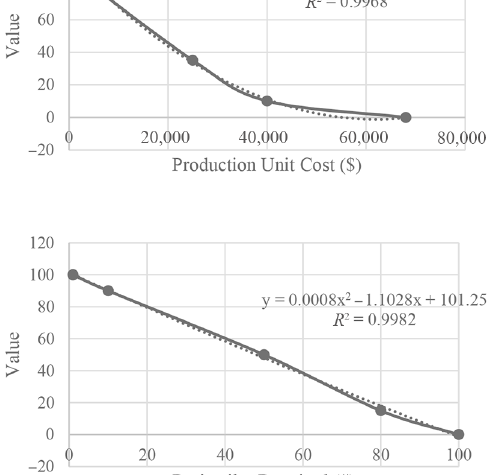
Figure 9. Expected number of projectiles required value